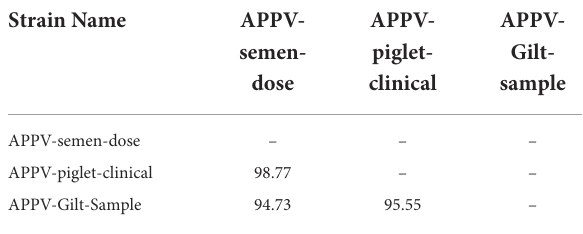
TABLE 1 Amino acid similarities (%) among atypical porcine pestivirus (APPV) E2 regions of 3 newly generated strains in this